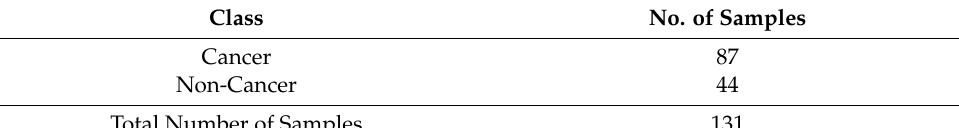
Table 1. Dataset details.